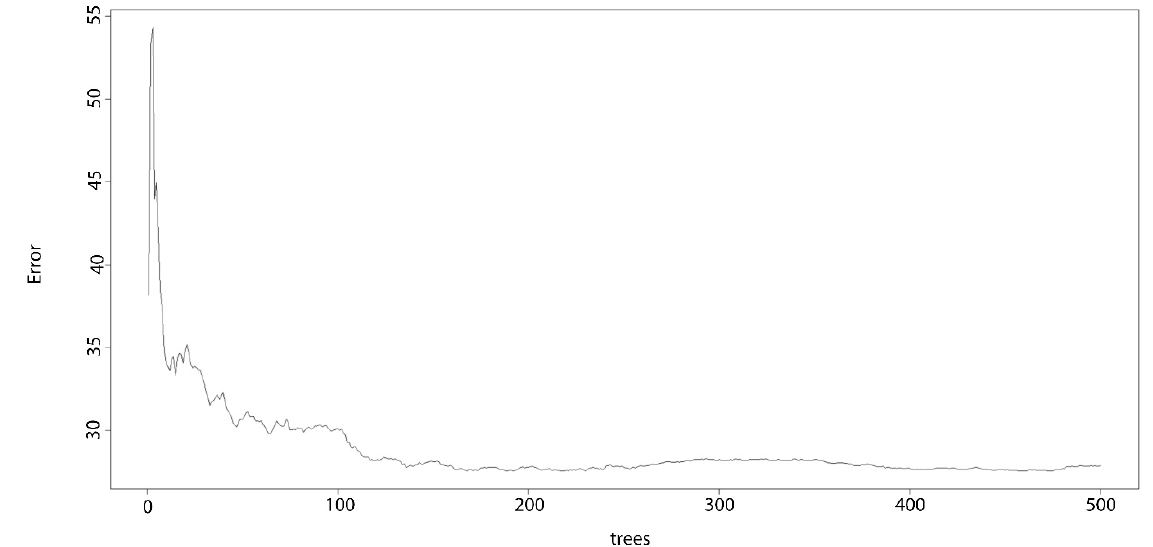
Figure 4. Training performances of the Random Forest model when seeking the best model to be selected.